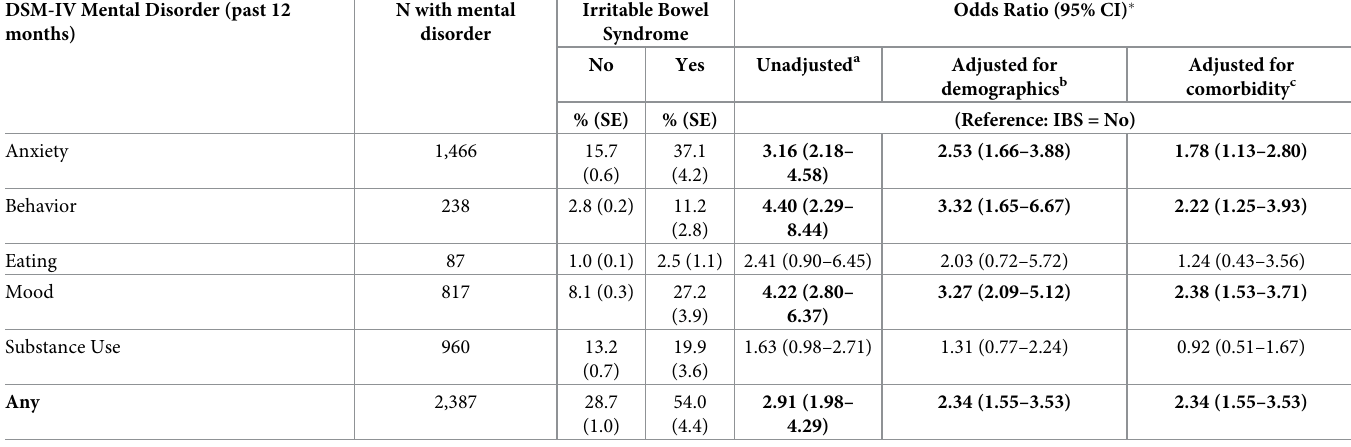
Table 2. Prevalence, unadjusted and adjusted risk of DSM-IV mental disorders in the adult IBS cohort in the NCS-R Part II survey. DSM-IV Mental Disorder (past 12